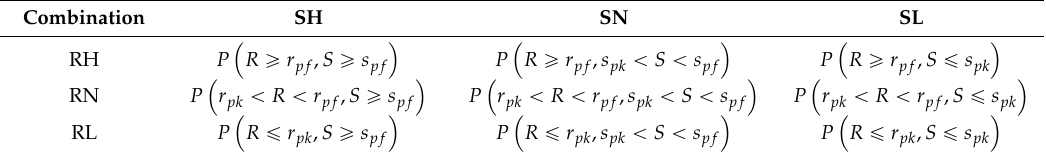
Table 2. The combinations of high-low annual runoff and sediment